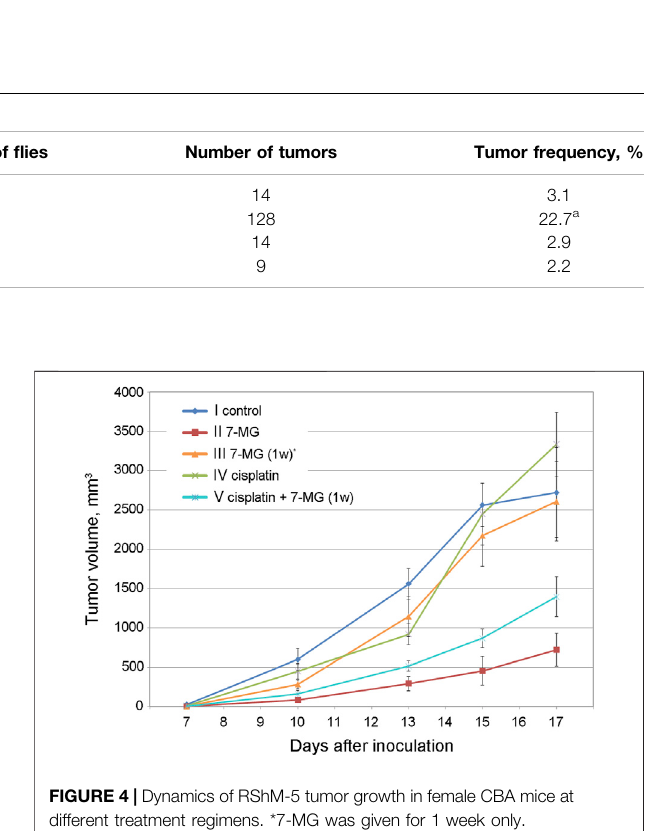
V control, males